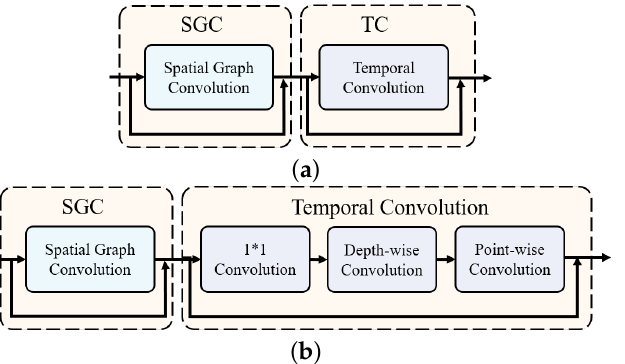
Figure 3. Illustration of the basic ST-GCN unit and the graph embedding. The SGC represents the spatial graph convolution module, and the temporal convolution adopts a separate convolution structure in our graph embedding. ( a ) Basic ST-GCN unit. ( b ) Graph